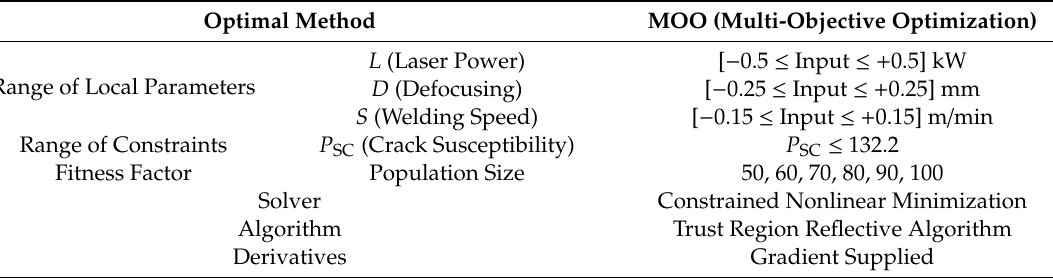
Figure 11. A flow chart for the Multi ‐ Objective Optimization (MOO) method to predict welding parameters. Table 12. MOO algorithm parameters and their Table 12. MOO algorithm parameters and their values.